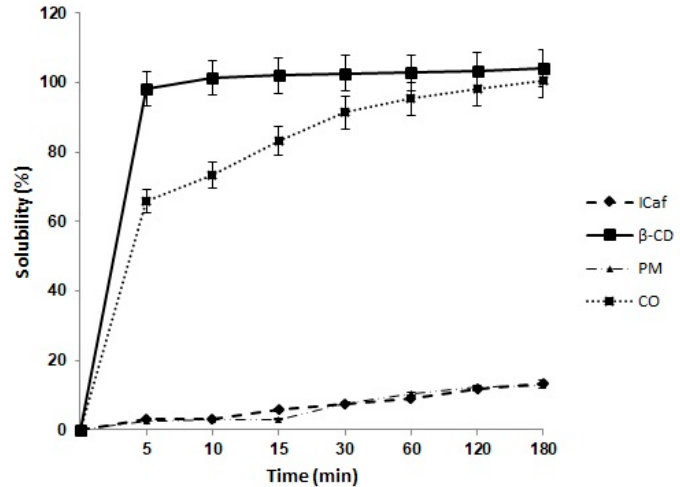
Figure 7. Comparison of the solubility profiles of Isopentyl Caffeate (ICaf), β -cyclodextrin ( β -CD) and inclusion complex (ICaf: β -CD) prepared by physical mixture (PM) and co-evaporation (CO) in 1:1 molar ratios ( n = 3).